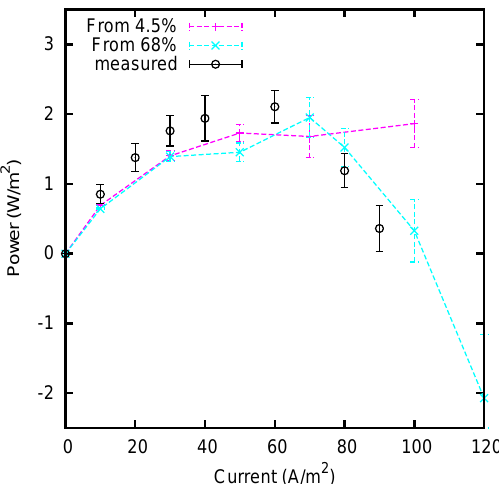
Figure 12. The average gained power in the AccMix cycles. The concentrations of the ZnCl = 4 : 5 % and c = 68 %. The lines represent an evaluation of the power solutions are c A C production obtained by subtracting the power dissipation, measured during charge/discharge cycles, from an “ideal” power production, obtained by assuming a voltage rise of 160 mV and no overvoltage. The reported power is an average over five consecutive cycles; the error bars represent the standard